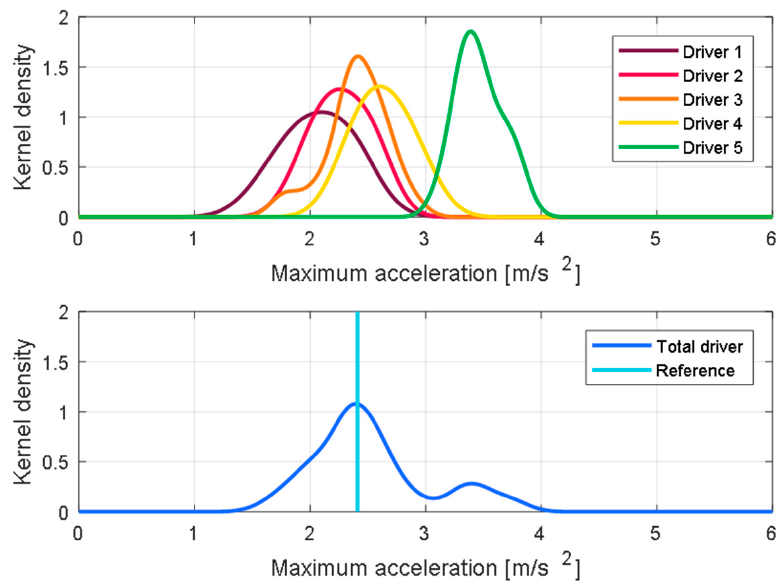
Figure 7. KDE of the maximum acceleration for each driver and the total number of drivers. Table 2. Median values of the driving features.